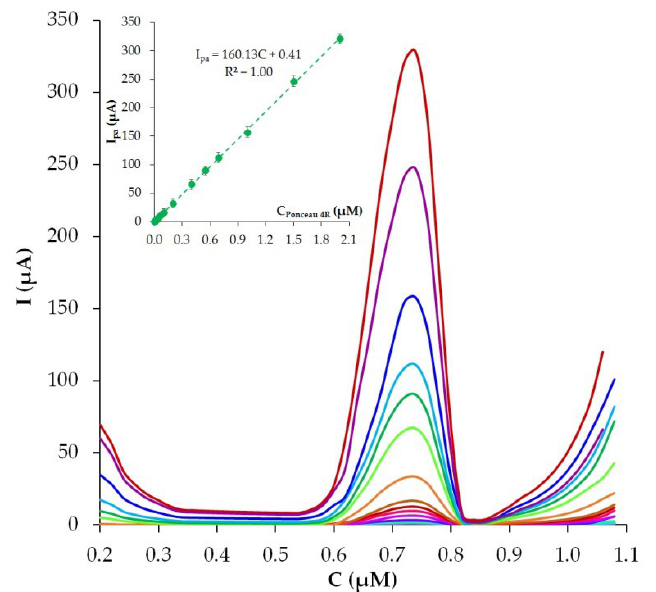
Figure 11. Differential pulse voltammograms of different Ponceau 4R concentrations (0.01–2 μM). Insert: I pa vs. C (Ponceau 4R) . Background: phosphate buffer solution pH 5, ν = 50 mV s − 1 , E acc = 0.0 V, t acc = 180 s.